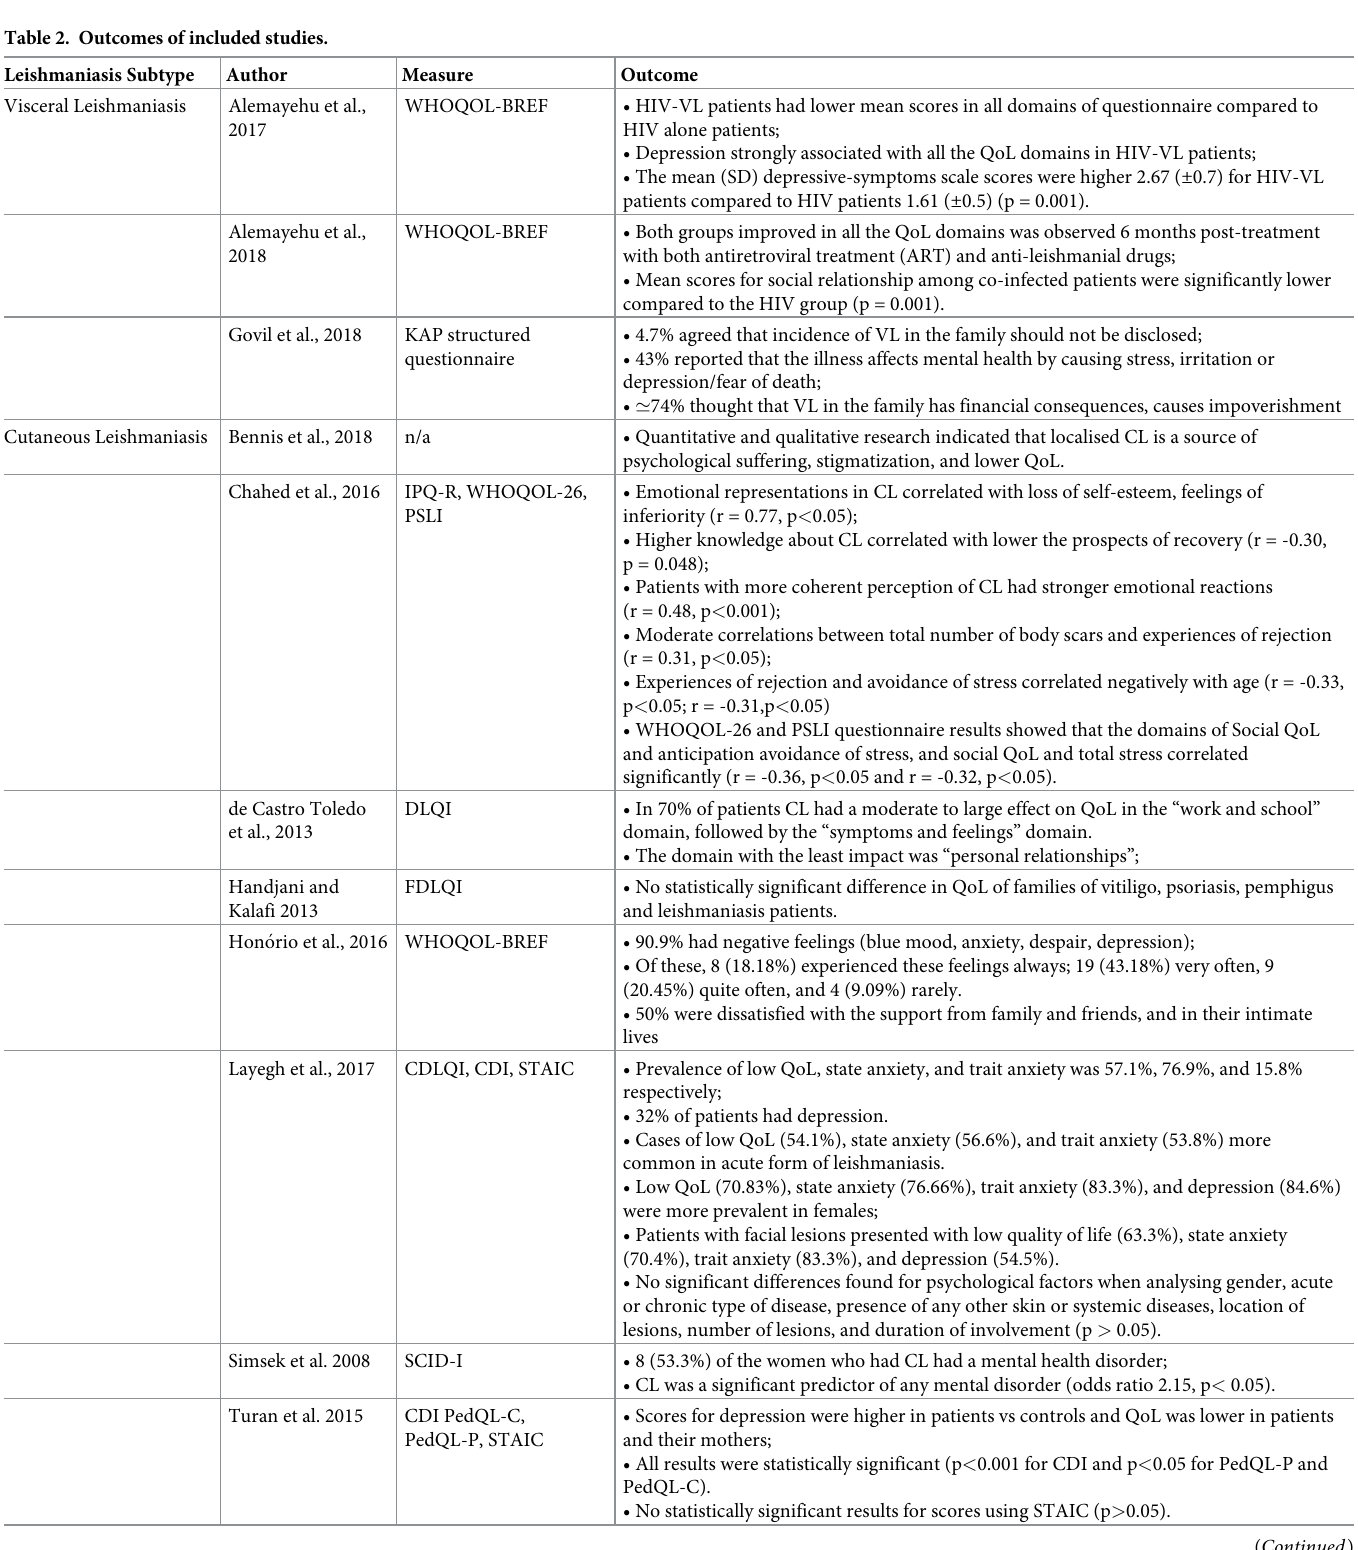
Table 2. Outcomes of included